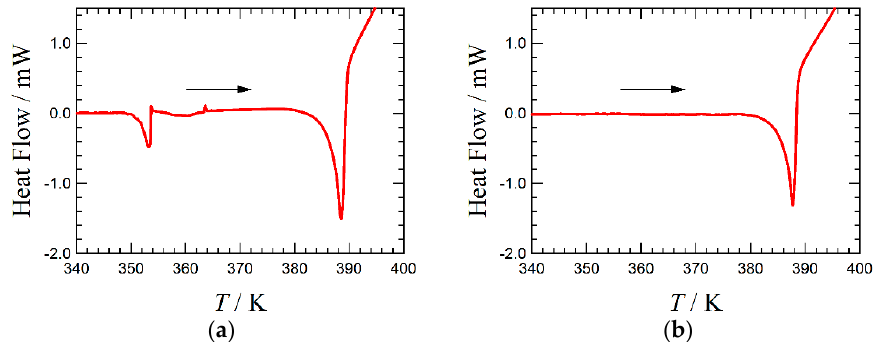
Figure 4. DSC profiles of ( a ) α - and ( b ) β -25MeBPBN.